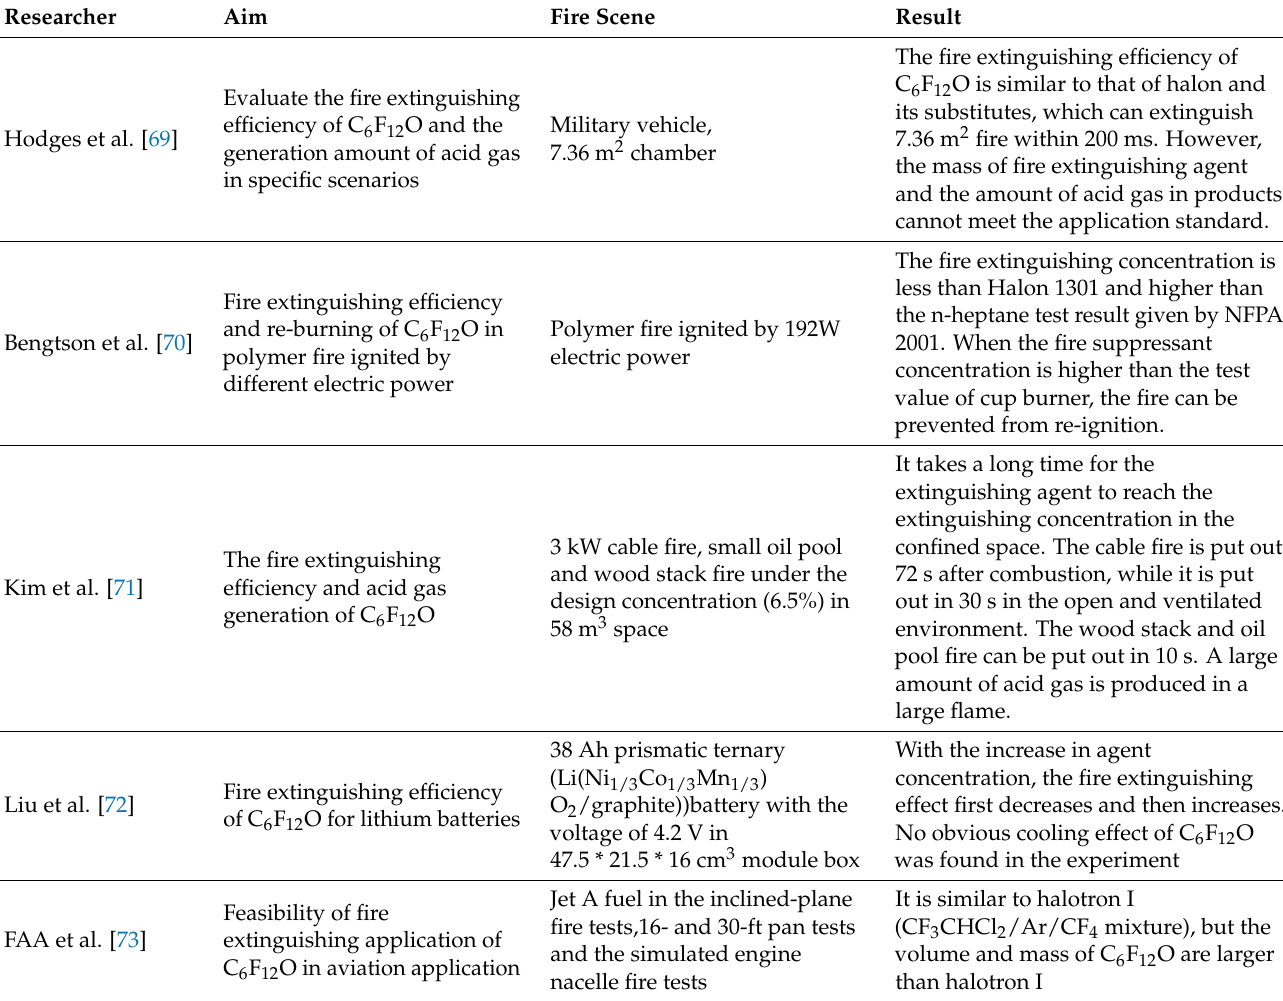
Table 7. Full-scale fire extinguishing experiments of